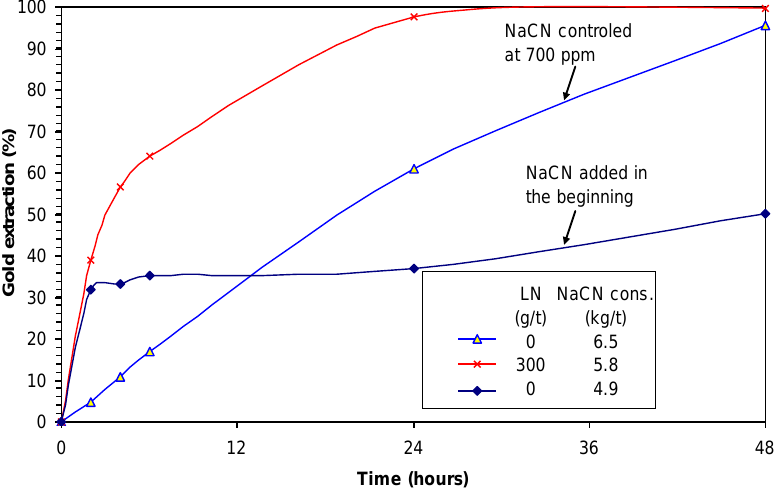
Figure 1. Effect of NaCN concentration and lead nitrate on gold extraction in presence of djurleite; 0.3% Cu, pH 11, 8 ppm